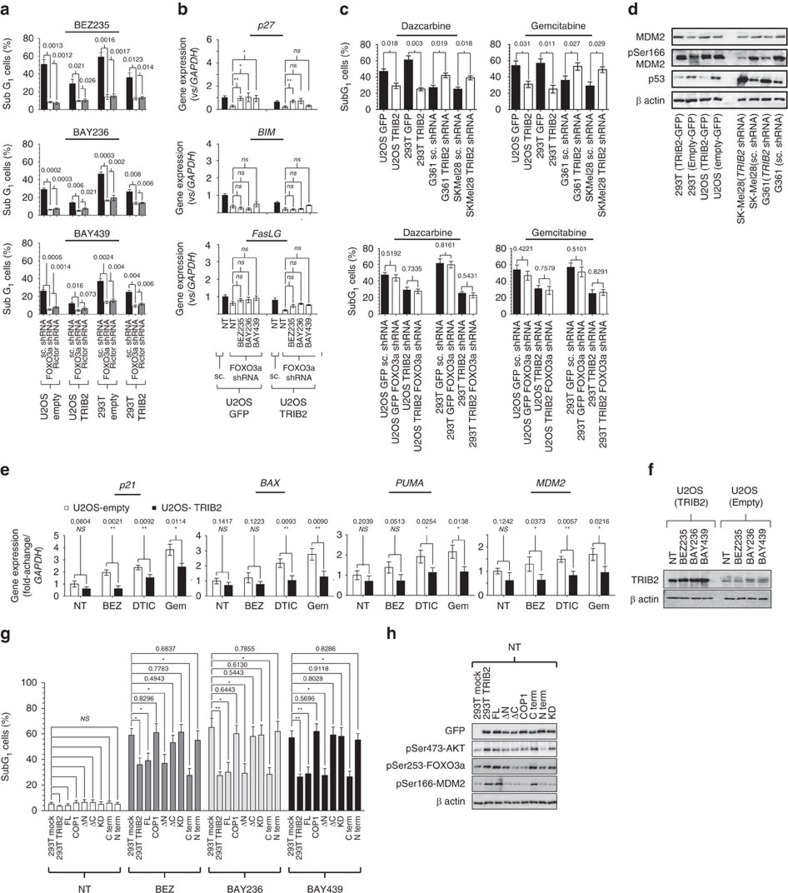
TRIB2-mediated resistance to chemotherapeutics is via AKT activation, suppressing FOXO3a and p53.(a) Matched isogenic TRIB2 cell line FACS analysis following the knockdown of FOXO3a and subsequent exposure to BEZ235, BAY236 (copanlisib) or BAY439 (BAY1082439) (n=6). P values are indicated for each comparison by two-way ANOVA and data represent the mean±s.d. (b) Quantitative real time PCR (qRT-PCR) analysis of FOXO3a-dependent gene expression after FOXO3a knockdown and isogenic cell line treatment for 24 h with PI3K inhibitors (n=6), (*P≤0.05, **P≤0.01 and were analysed by two-way ANOVA). Data represent the mean±s.d. (c) Matched isogenic TRIB2 cell line FACS analysis after 72 h exposure to various chemotherapeutics (n=6). P values are indicated for each comparison and data represent the mean±s.d. (d) I Representative immunoblot analysis showing 50 μg (MDM2), 100 μg (MDM2-Ser166), 50 μg (p53) total protein lysate per lane separated by 6–10% SDS–PAGE. (e) p53-dependent gene expression was evaluated following TRIB2 isogenic cell line treatment with each indicated chemotherapeutic agent for 24 h. P values are shown for comparison by 2-way ANOVA (*P≤0.05, **P ≤0.001, ***P ≤0.0001) and data shown indicates mean±s.d. (f) Representative immunoblot analysis showing TRIB2 protein expression (100 μg total protein loaded per lane) following exposure to each indicated PI3K inhibitor. (g) FACS analysis of 293T cells after transfection of each TRIB2 construct and subsequent exposure to BEZ235, BAY236 (BAY 80-6946) or BAY439 (BAY1082439) (n=6) for 72 h. P values are indicated for each comparison by two-way ANOVA and data represent the mean±s.d. P values are shown for each comparison where no significant difference was noted. Data was analysed by 2-way ANOVA *P≤0.05, **P≤0.001. (h) Representative immunoblot analysis showing 50 μg (GFP), 100 μg (AKT-Ser473), 100 μg (FOXO3a-Ser253), 100 μg (MDM2-Ser166) protein expression 48 h post-transfection of the indicated GFP tagged TRIB2 plasmid constructs.